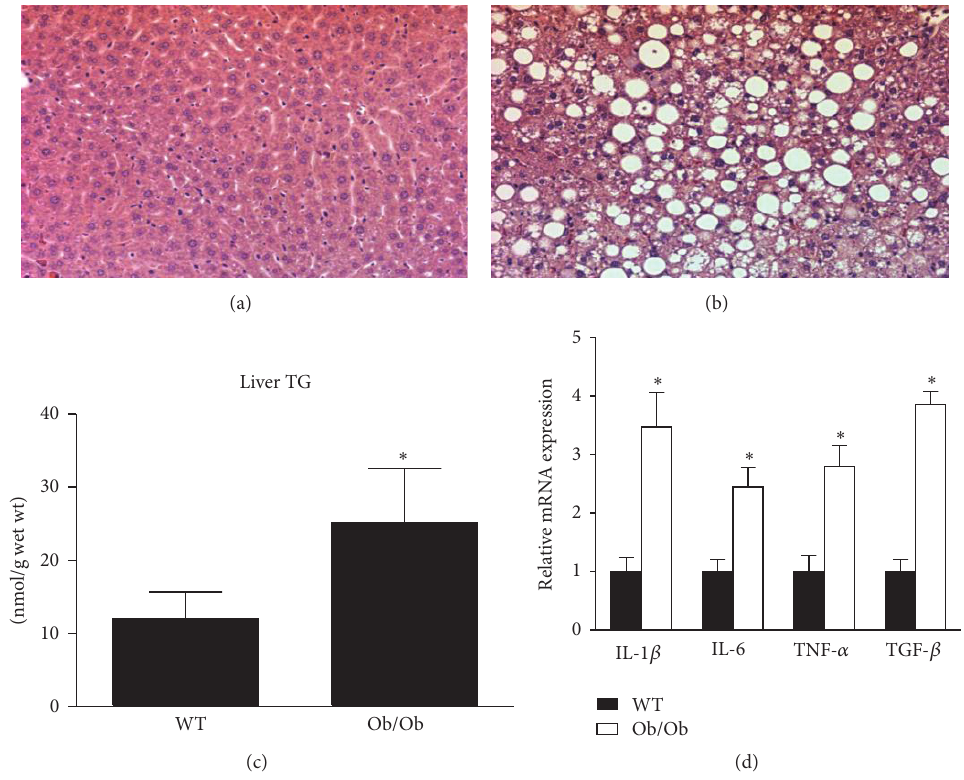
F 2: Ob/Ob mice display hepatic lipid accumulation and increased hepatic in�ammation. Representative H�E stained images from the livers of age-matched wild-type (WT) (a) and Ob/Ob (b) mice fed a standard rodent chow. Triglyceride content (c) and relative gene expression of in�ammatory factors (d) were signi�cantly increased in the livers of Ob/Ob mice. �alues are